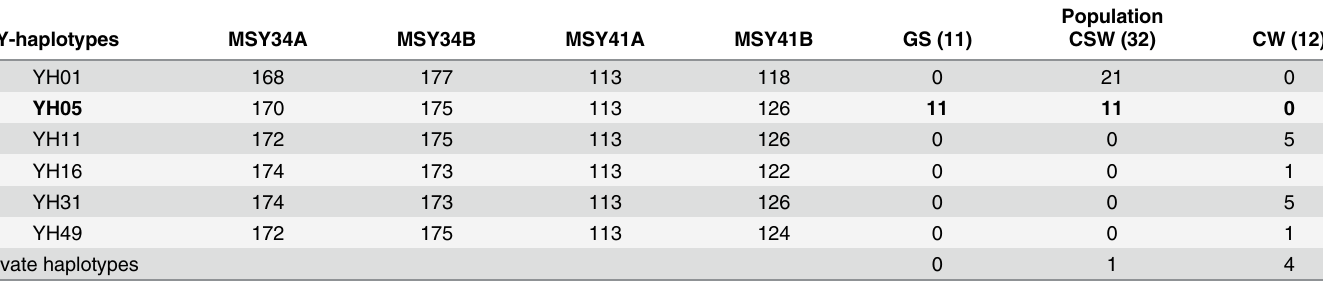
Table 1. Distribution of the Y-linked microsatellite haplotypes as named by Randi et al. (2014). For all haplotypes, the alleles of each locus are listed.